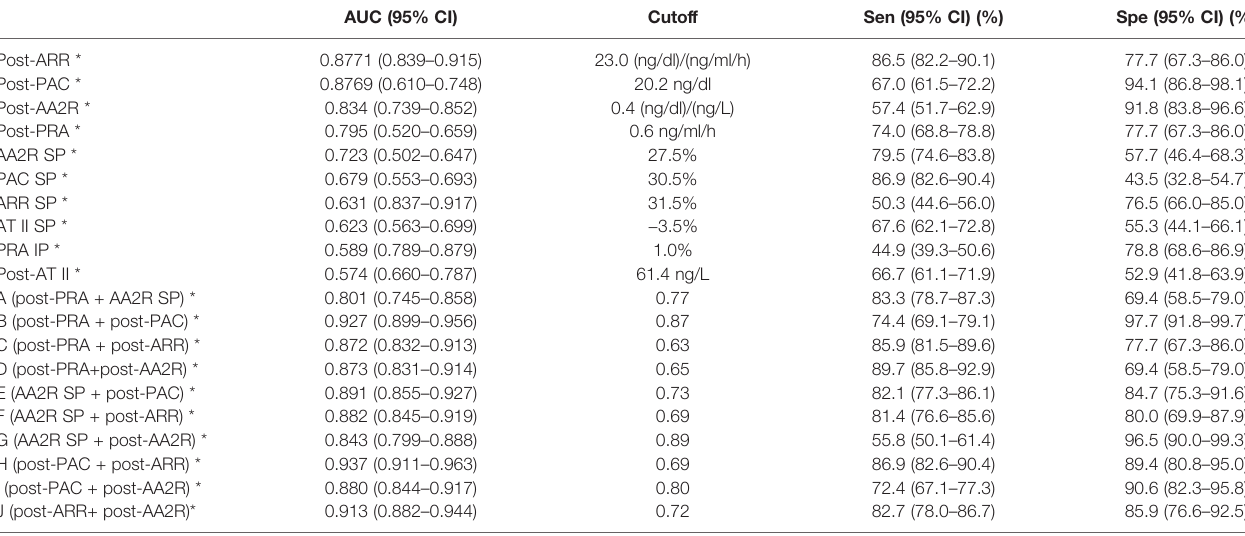
TABLE 3 | The value of different CCT-associated single and combined indexes for distinguishing between PA and